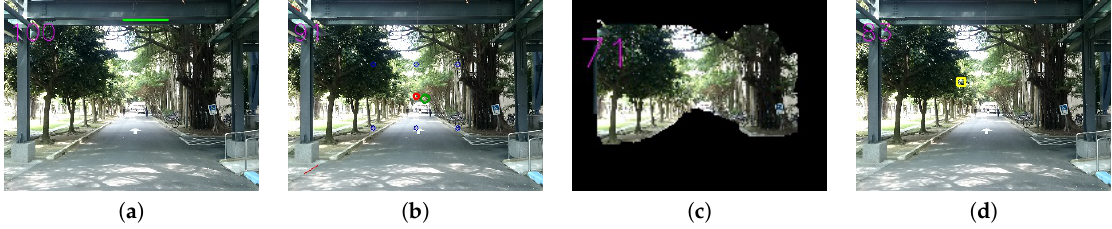
Figure 32. ( a ) Horizontal composition. ( b ) Vanishing point composition. ( c ) Frame within a frame composition. ( d ) Focus